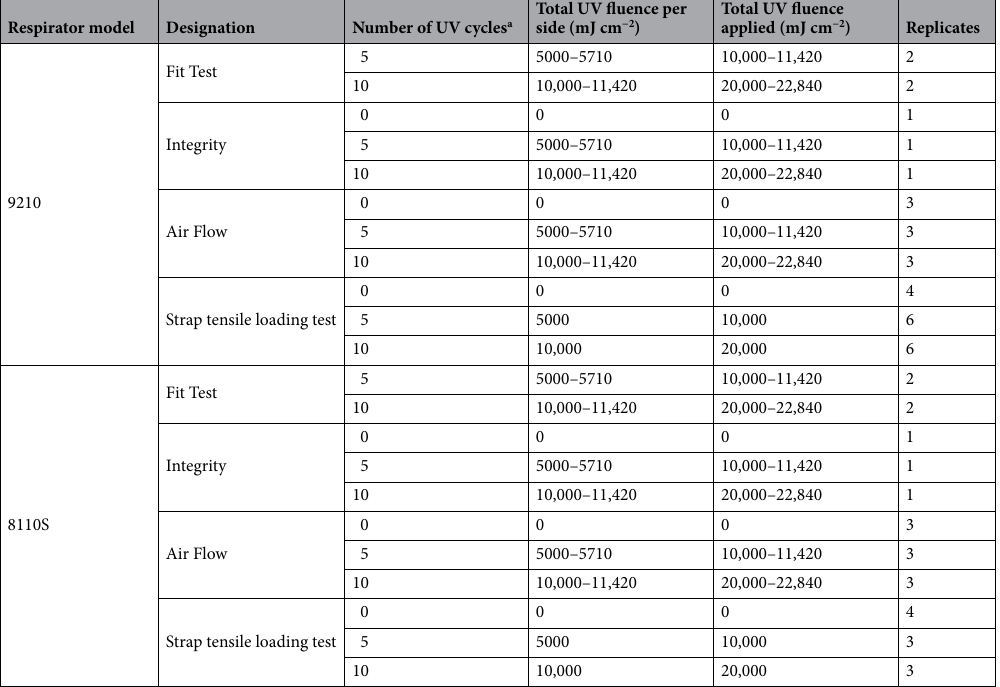
Table 1. Experimental design for integrity test after UV treatment on N95 respirators (9210 and 8110S models). a Each UV cycle consisted of a 180-s treatment duration per side of the respirator. In treating each side of the respirator, a full UV cycle (360 s) delivered a fluence of 1000 and 1142 mJ cm −2 to the farthest and closest point on the respirator to the light source, respectively. Over five cycles, the total fluence applied to each respirator was 10,000 mJ cm −2 (for the region of the respirator farthest from the light source) and 11,420 mJ cm −2 (for the areaof the respirator closest to the light source). Similarly, 10 UV cycles delivered a total fluence for each FFR of 20,000 to 22,840 mJ cm −2